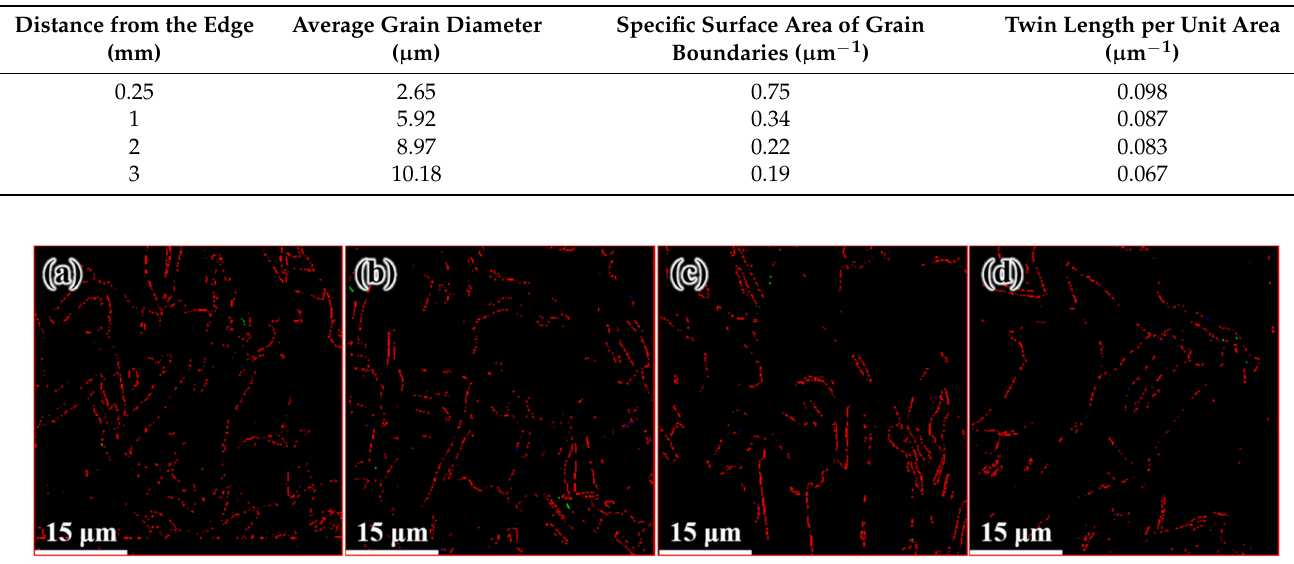
Figure 13. Distribution of twin boundary after CE at room temperature: ( a ) 250 µ m from the edge, ( b ) 1 mm from the edge, ( c ) 2 mm from the edge and ( d ) 3 mm from the edge.